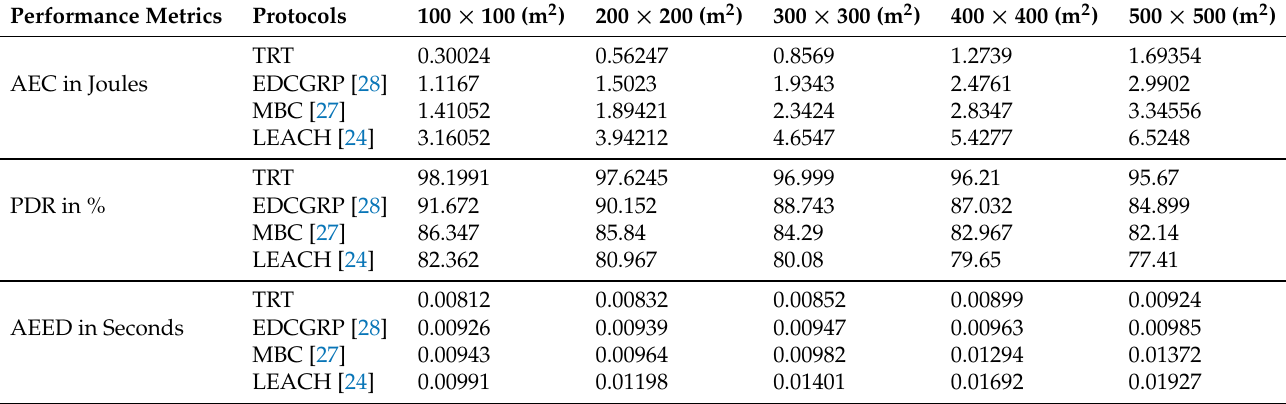
Table 4. Impact of increase in network